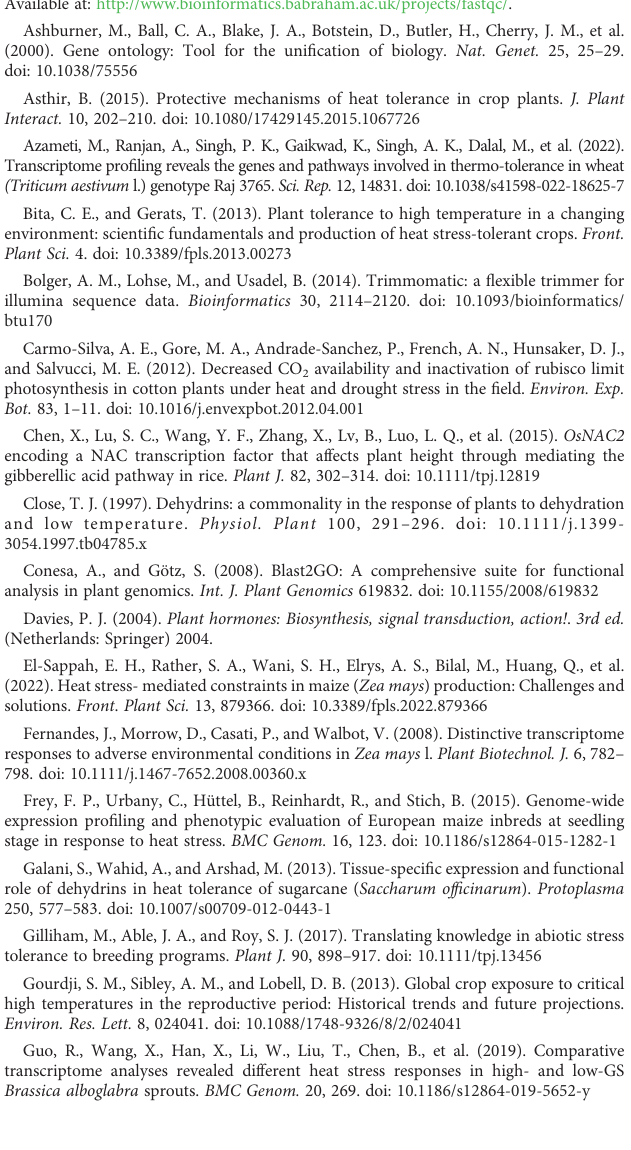
SUPPLEMENTARY FIGURE 1 Principal component analysis (PCA plot) of all RNA-seq maize samples at reproductive stage under heat stress. SUPPLEMENTARY FIGURE 2 Heatmap of differentially expressed genes (DEGs) in response to heat stress. DEGs have been identi fi ed with signi fi cant (P < 0.05) and |log 2 (fold change)| ≥ 2 in leaf, pollen and ovule of CML 25 (HT) and LM 11 (HS) inbred. Colors represent log 2 up-regulation (yellow) and down-regulation (blue) of